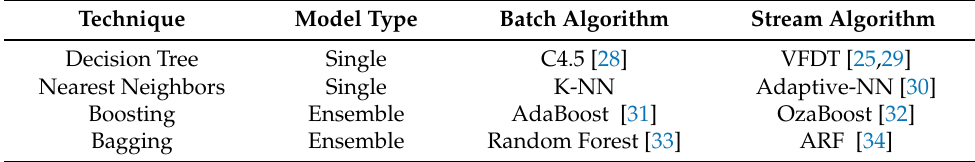
Table 1. Equivalent of four popular classification techniques for classifying the data stream. Technique Model Type Batch Algorithm Stream Algorithm Decision